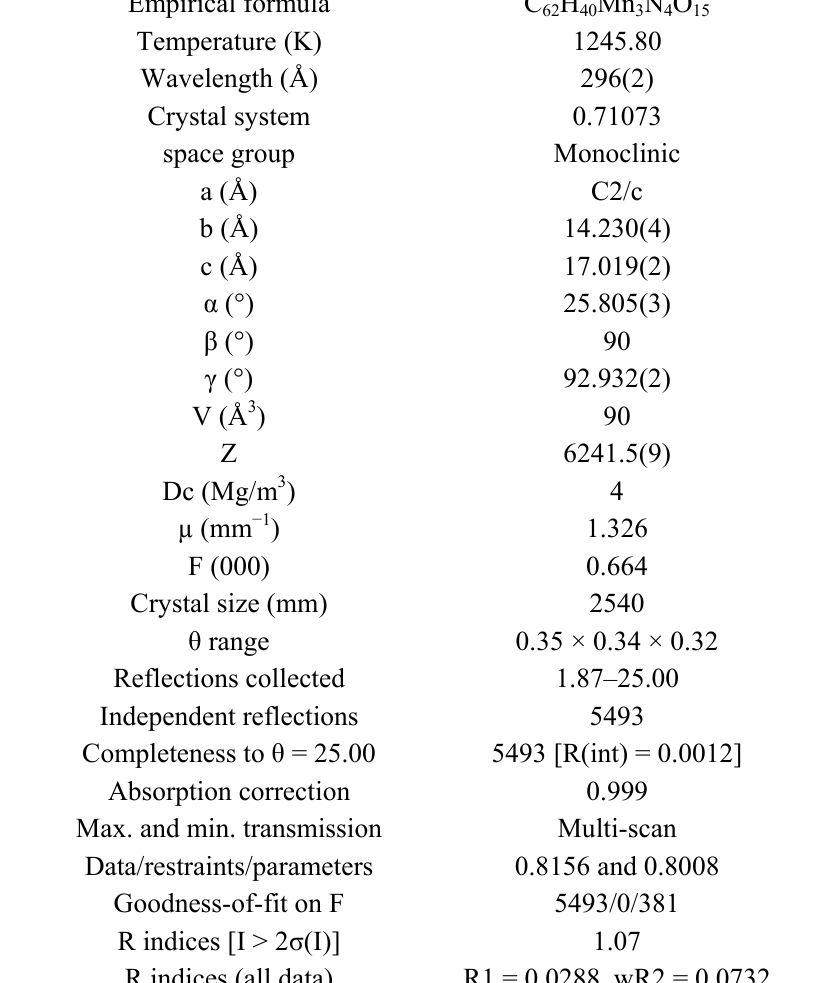
Table 1. Experimental data for complex 1 .